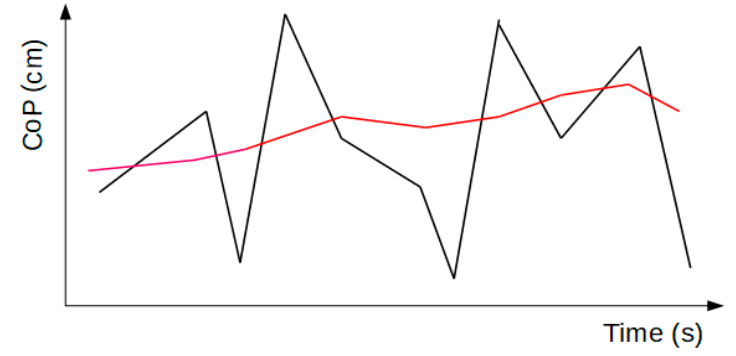
Figure 9. Schematic representation of a filtered signal (red) and its counterpart with the murmur (black).